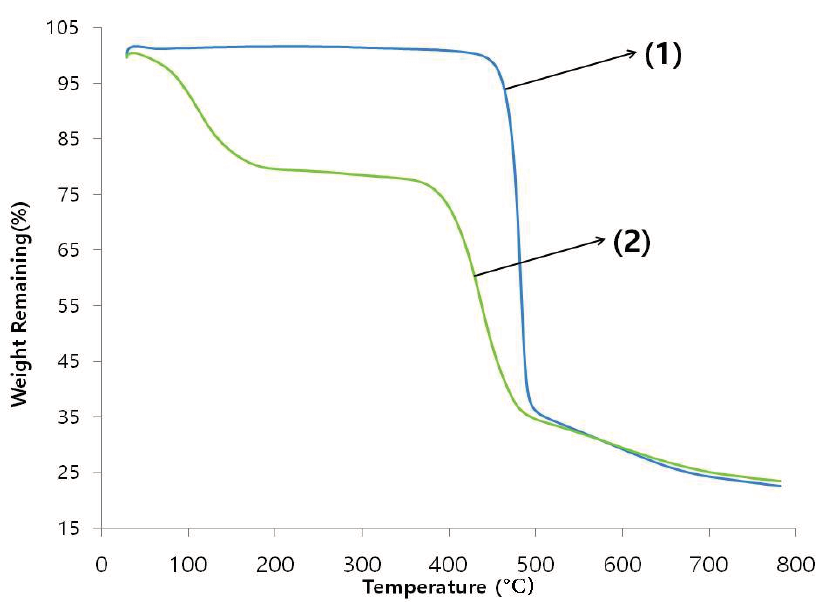
Figure 4. TGA graphs of ( 1 ) PVDF and ( 2 )